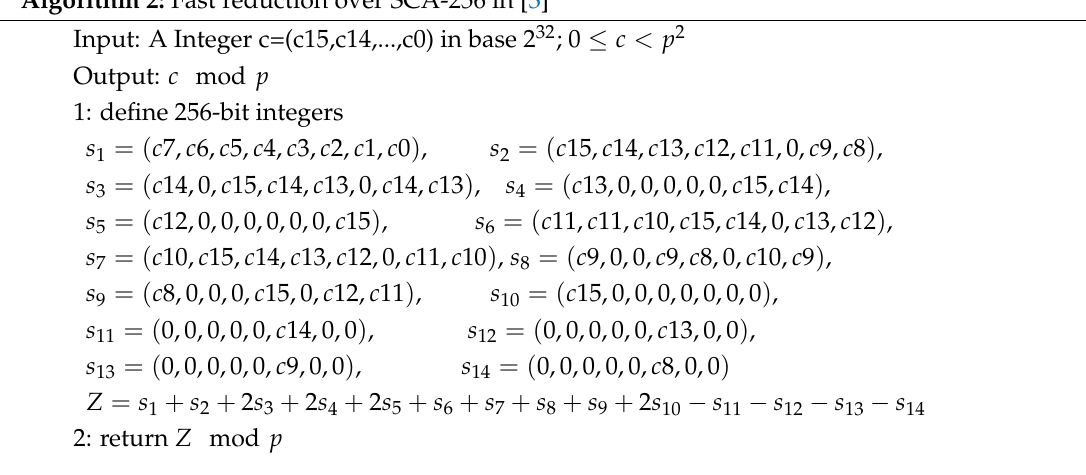
Algorithm 2: Fast reduction over SCA-256 in [3]